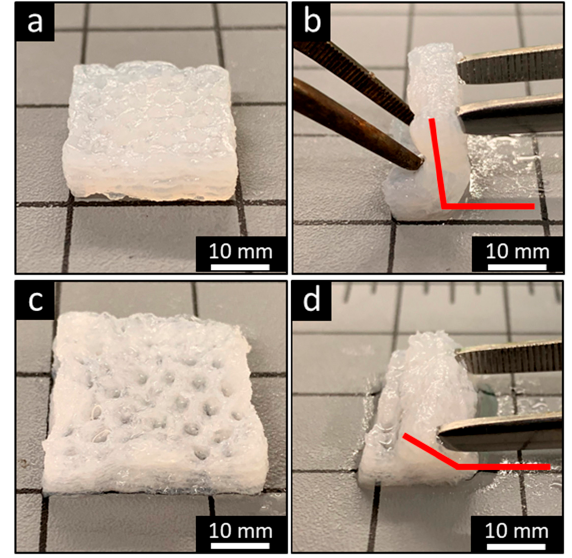
Figure 4. Mechanical properties of FF scaffolds. Bulk ( a ) and wall ( b ) stiffness in wet conditions of smooth, FF frozen at − 20 °C and − 80 °C, and FC scaffolds. (*) denotes significant difference where p < 0.05.